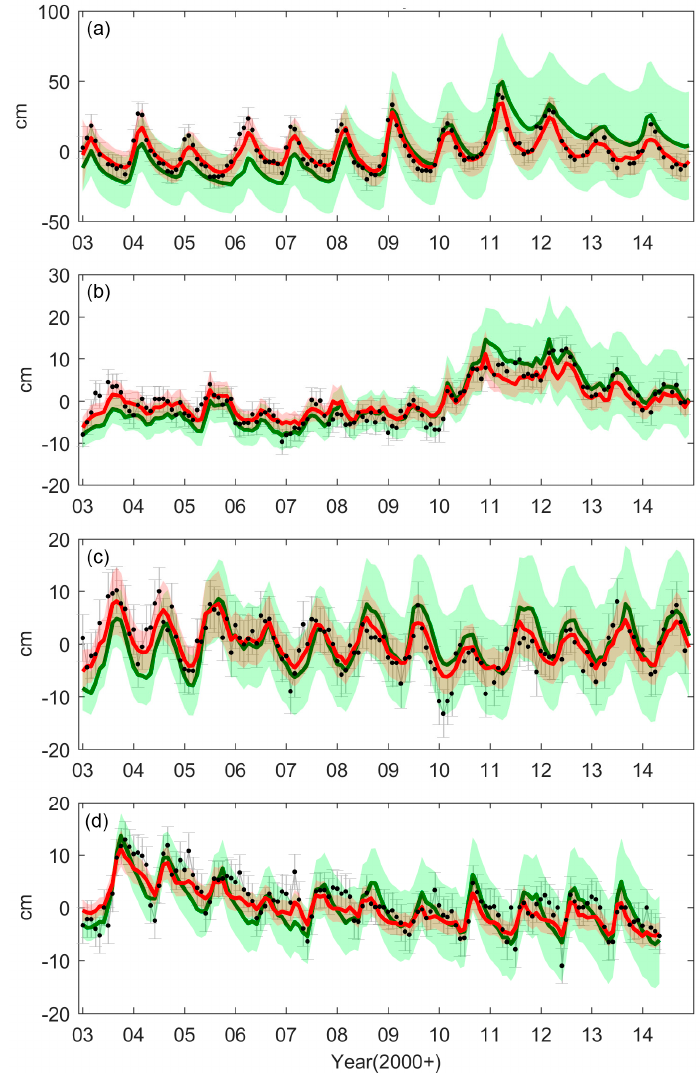
Figure 2. The Δ TWS estimates from PCR-GLOBWB (EnOL, green), GRACE DA (EnKS 3D, red), and the GRACE observation (black) in the GOC ( a ); MRD ( b ); SWC ( c ); and the NCP ( d ). The uncertainties of the Δ TWS estimates are also shown.